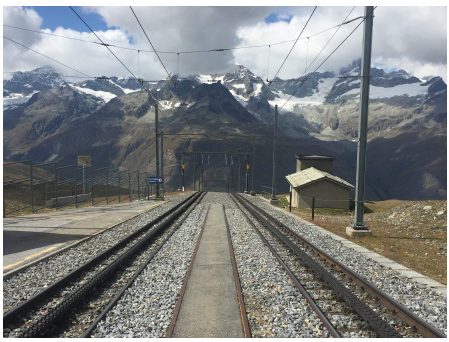
Figure 12. An example image using the vanishing point